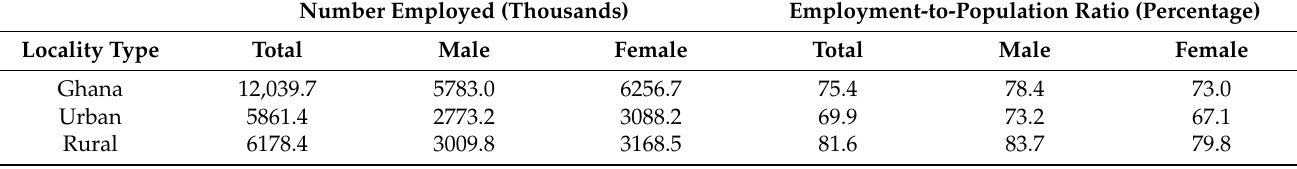
Table 6. Number of currently employed persons and employment-to-population ratios. (persons 15 years and older) by locality type and sex. Number Employed (Thousands) Employment-to-Population Ratio (Percentage) Locality Type